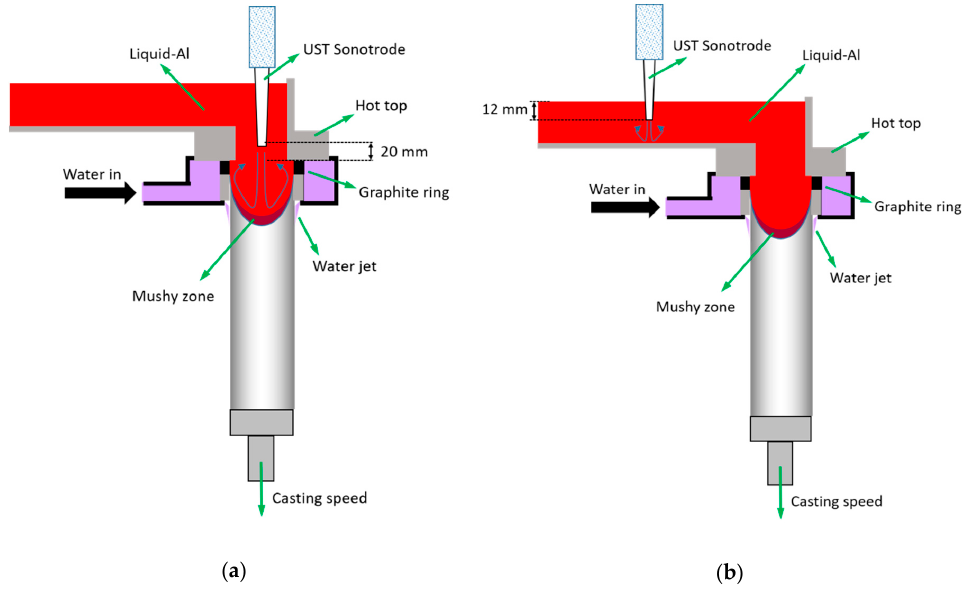
Figure 1. Illustration of DC casting setup and different locations of ultrasonic melt treatment (UST). ( a ) On the DC casting ( a ) On the DC casting hot-top, and ( b ) on the DC casting launder. The effect of UST on microstructure was verified through grain size analysis. For